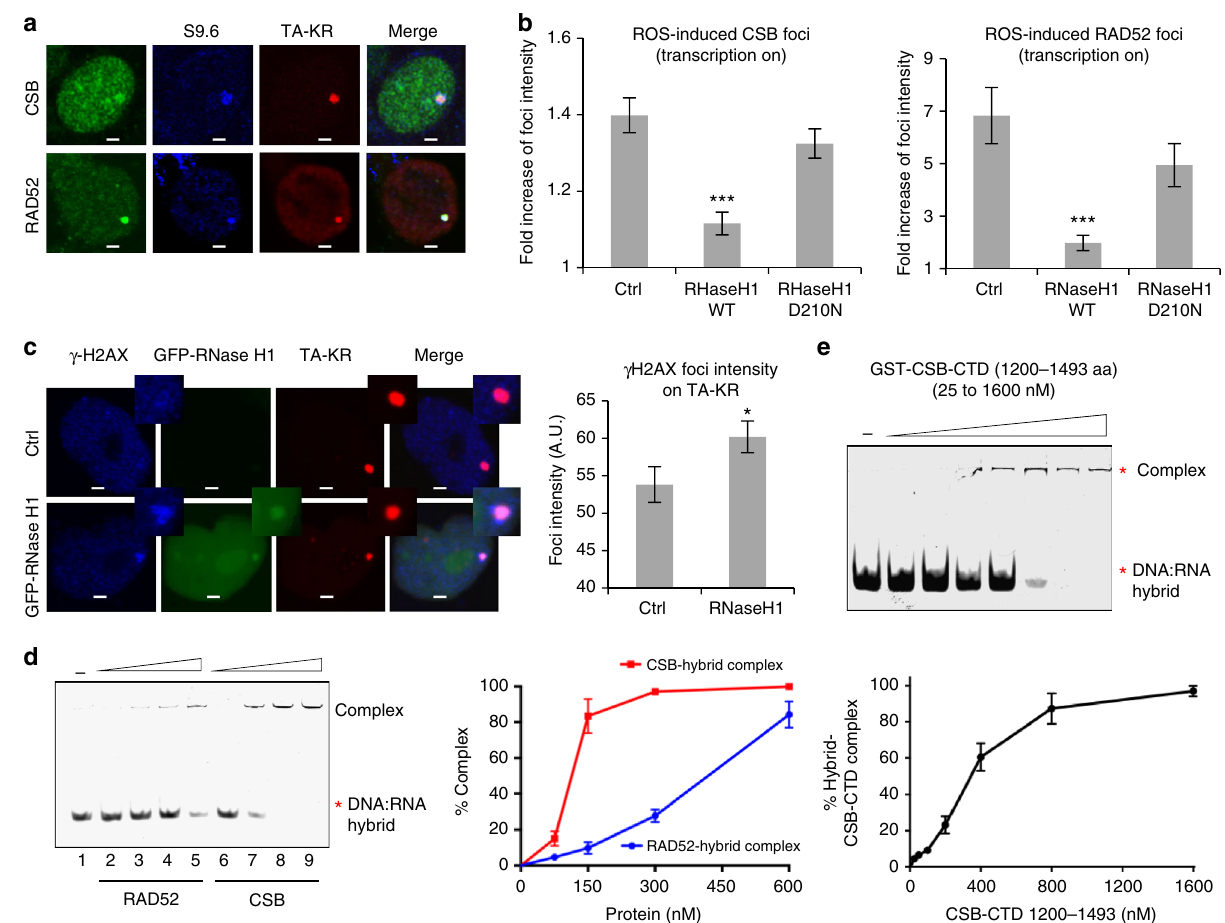
Fig. 5 ROS-induced R loops activate TC-HR through CSB. a Colocalization of CSB or GFP-RAD52 with S9.6 foci at TA-KR (scale bar: 2 μ m). b Myc-CSB or GFP-RAD52 foci relative intensity at TA-KR in cells overexpressed with HA-RNase H1 WT or D210N mutant ( n = 10 cells in one experiment). c γ H2AX foci (36 h) intensity at TA-KR in cells transfected with GFP-RNaseH after damage induction ( n = 50 cells in one experiment, scale bar: 2 μ m). For b and c , error bars represent SEM. d In vitro binding of CSB and RAD52 proteins to DNA:RNA hybrids in an electrophoretic mobility shift assay (EMSA). e DNA:RNA hybrids EMSA assay of puri fi ed GST-CSB-CTD (1200 – 1493) protein. For d and e , n = 3, error bars represent SD. Unpaired t -test, * P < 0.05, ** P < 0.01, *** P <